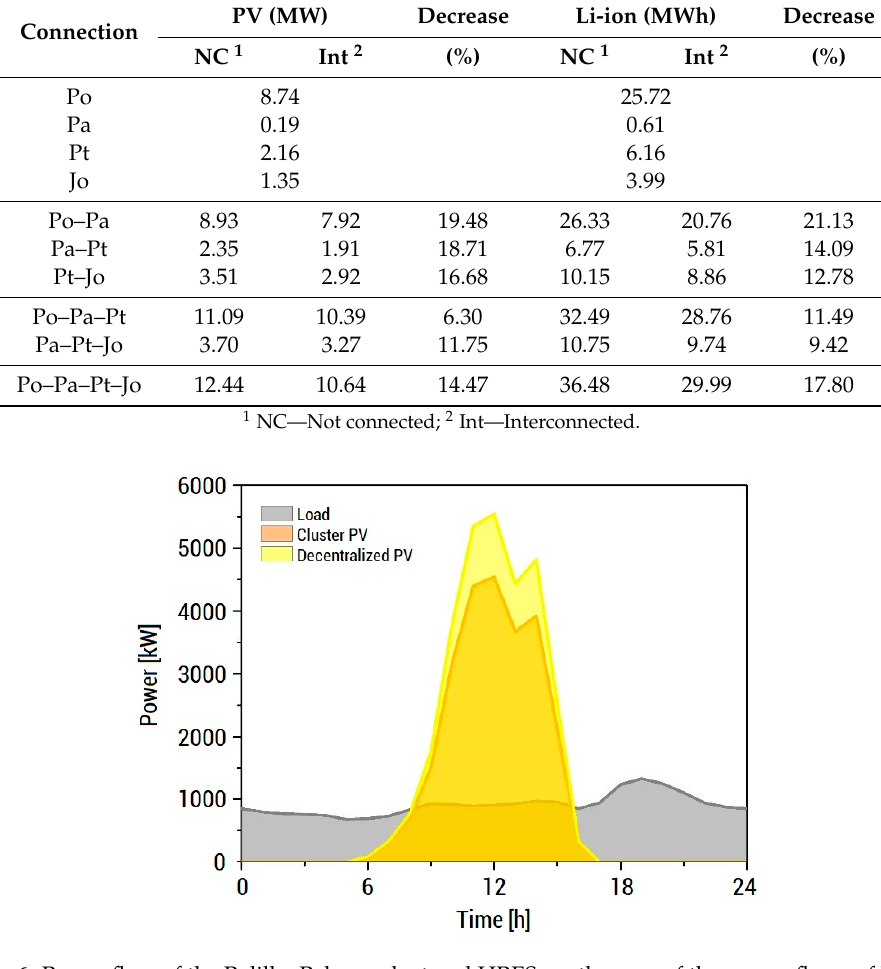
Figure 6. Power flow of the Polillo–Palasan clustered HRES vs. the sum of the power flows of Polillo and Palasan if they were not connected.